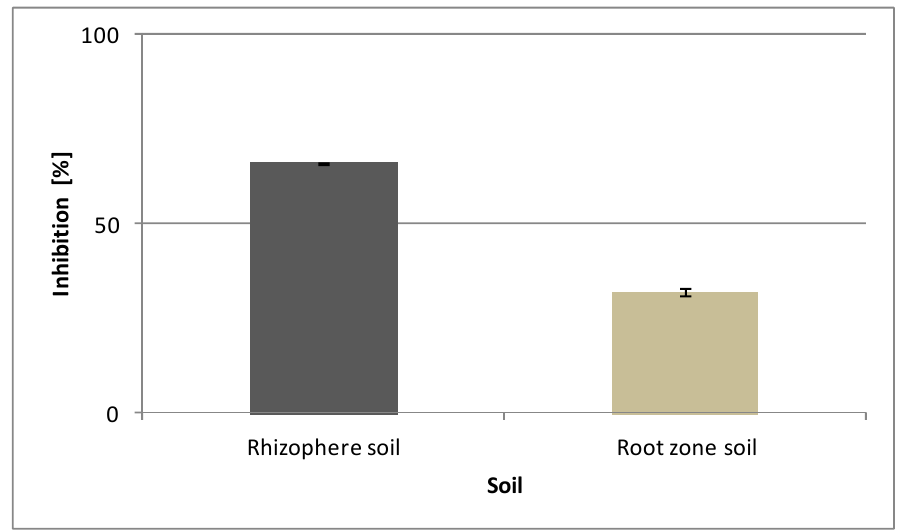
Figure 3. The effect of the phytotoxicity of rhizosphere soil and root-zone soil on the growth of lettuce seedlings by the rhizosphere soil method. The data are the mean of three replications ± SD.